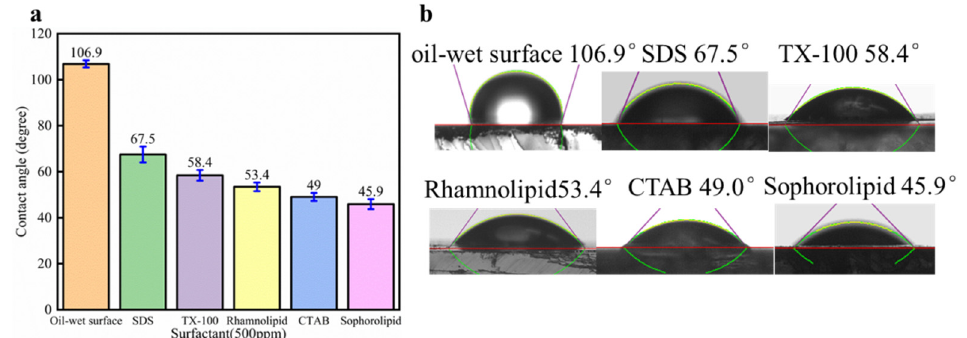
Figure 18. Effect of surfactants alone on oil-wet calcite wettability. ( a ) Contact angle histogram; ( b ) Measurement figure.